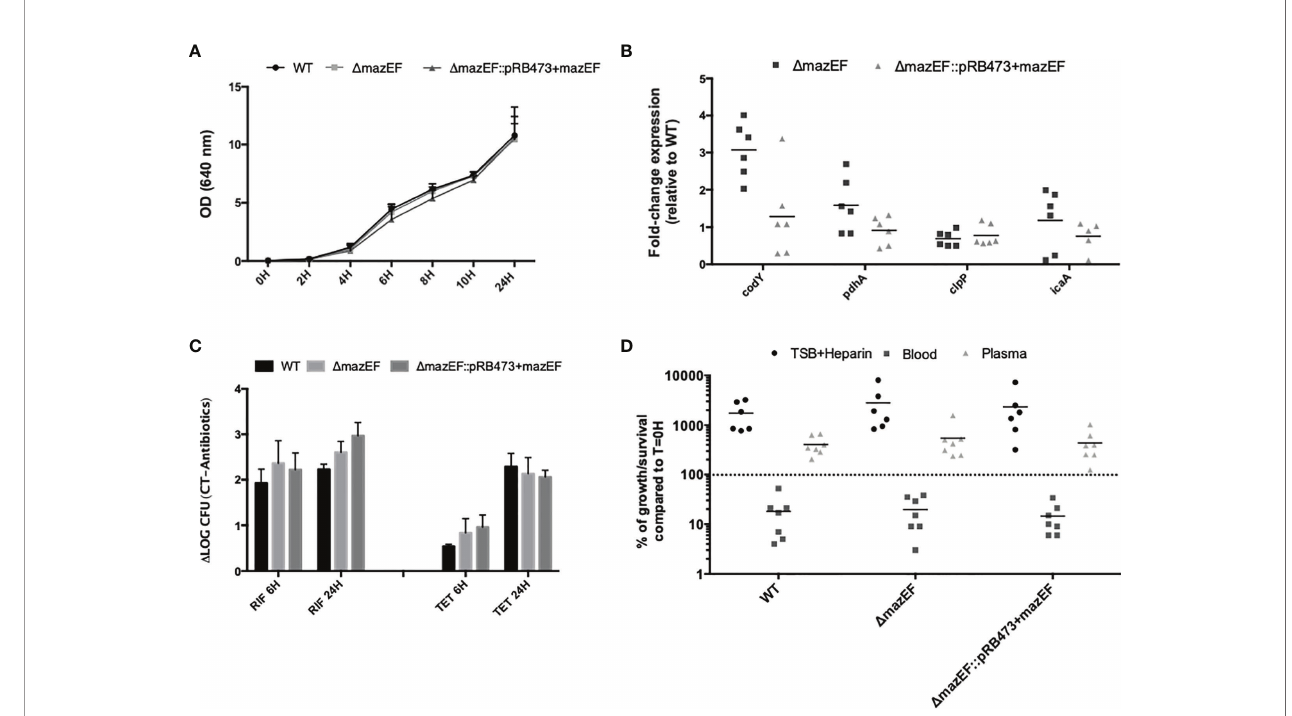
FIGURE 2 | Characterization of the role of mazEF homologue constructs in S. epidermidis 1457 phenotype and virulence potential. (A) Growth curve of S. epidermidis strains as determined by optical density (OD 640 nm); (B) Fold-change expression in 48 hour-old bio fi lms formed by all strains. The values obtained in the WT strain were used as control. Each point represents a single experiment and the horizontal lines the mean of at least 5 independent experiments; (C) Effect of rifampicin (RIF) and tetracycline (TET) on the culturability of 48-hour old bio fi lm cells. Results are presented as the LOG difference between the control samples (no antibiotic) and the antibiotic-treated samples ( D LOG); (D) Survival of S. epidermidis strains in human blood and plasma upon 4 h of incubation. Each point is relative to a different donor/assay and the horizontal lines represent the median of 6 independent experiments performed with different donors (3 females and 3 males). TSB supplemented with heparin (TSB + Heparin) was used to evaluate the effect of heparin on bacterial growth. Results (A, C) are presented as the mean + standard deviation of at least 3 independent assays. Statistical analysis was performed using One-way ANOVA with Tukey ’ s multiple comparisons test for all the